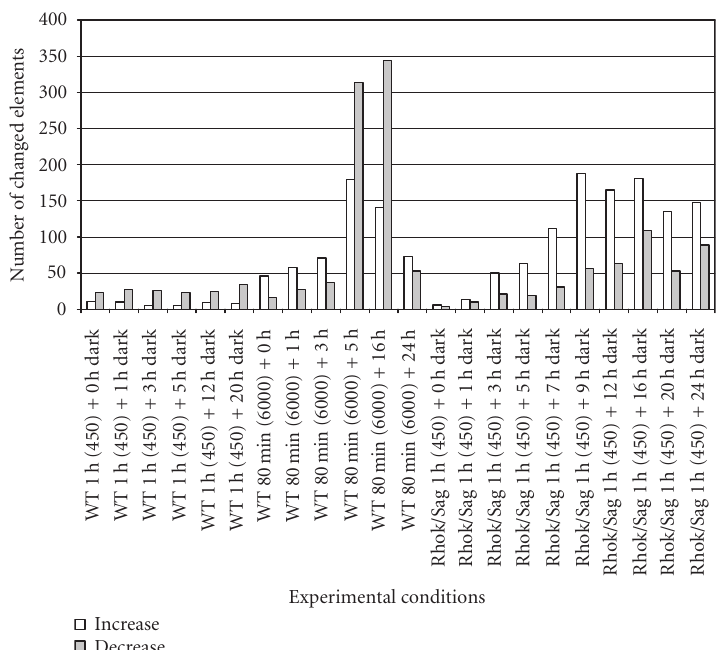
Figure 1: Number of upregulated and downregulated genes in wild-type and rhodopsin kinase/arrestin knock-out (Rhok − / − /Sag − / − ) after dark adaptation for indicated